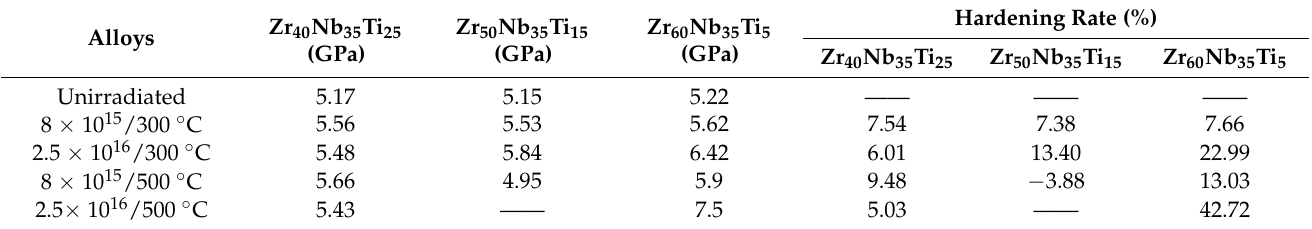
Table 5. Average nanohardness and hardening rate of Zr-Nb-Ti MEAs in the range of 200–400nm from the surface under different irradiation